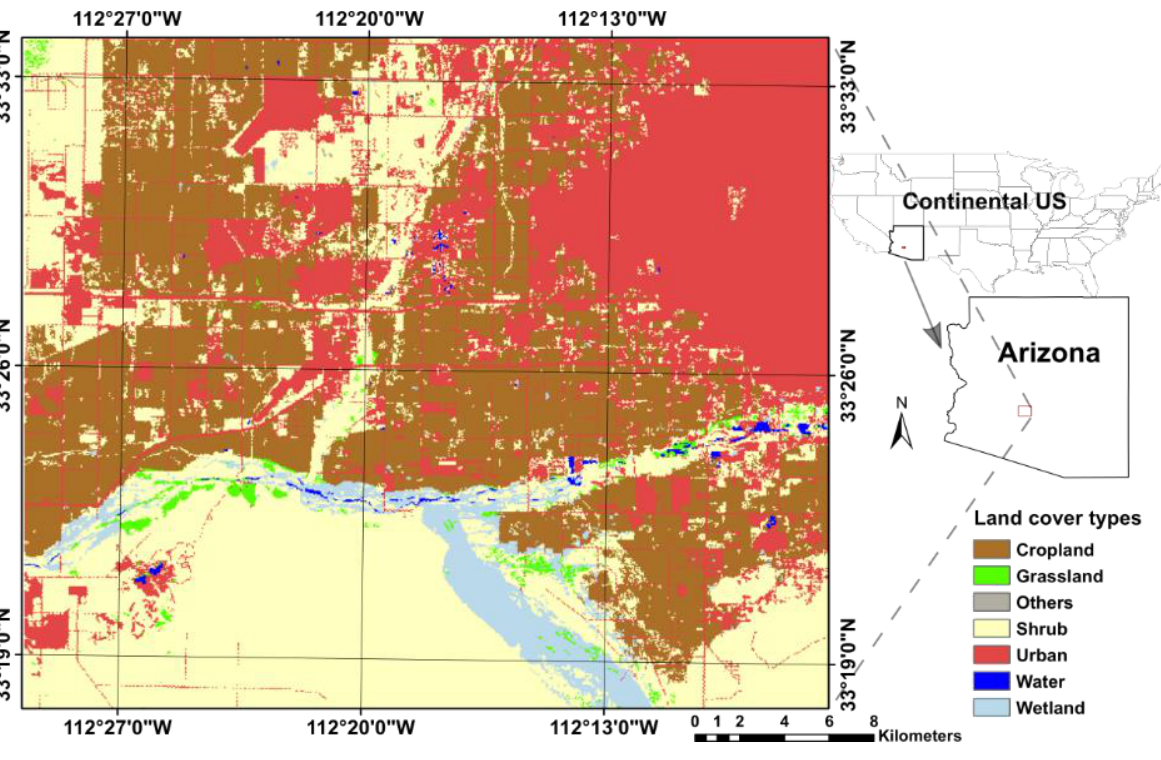
Figure 1. Land cover map (National Land Cover Database (NLCD), year: 2001) of the study area.